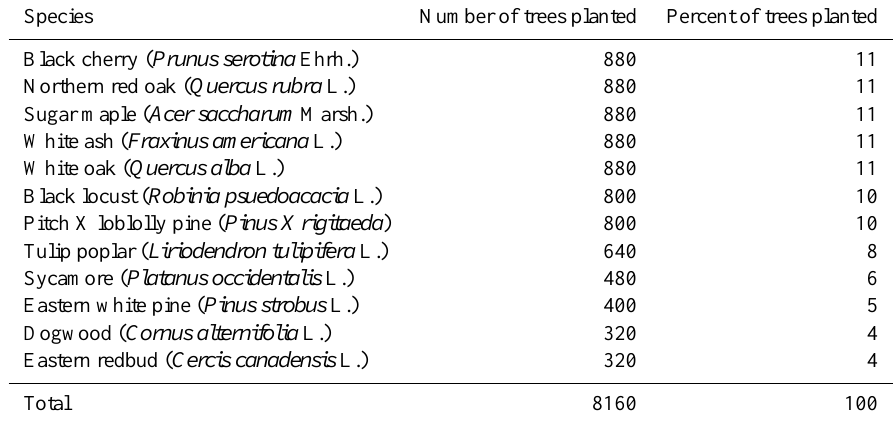
Table 1. Species and number of trees planted in 2007 at the Arch–Birch River mine in Webster County, West Virginia. Species Number of trees planted Percent of trees planted Black cherry ( Prunus serotina Ehrh.) 880 Northern red oak ( Quercus rubra L.) 880 Sugar maple ( Acer saccharum Marsh.) White ash ( Fraxinus americana L.) White oak ( Quercus alba L.) Black locust ( Robinia psuedoacacia L.)